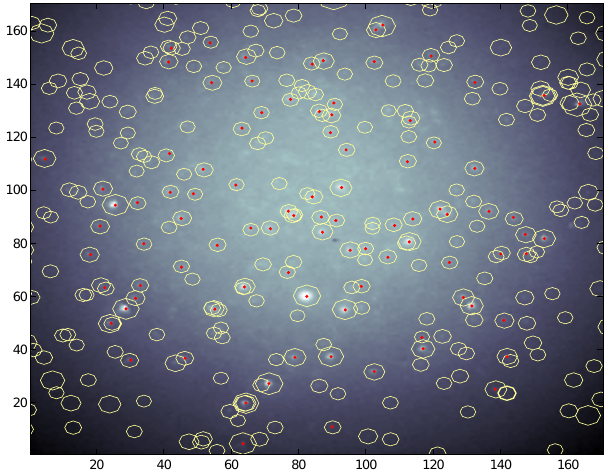
Fig. A6. Same as Fig. A2, but for the ST-9 imager located at the HIPAS site, observation in 6300 ˚A.